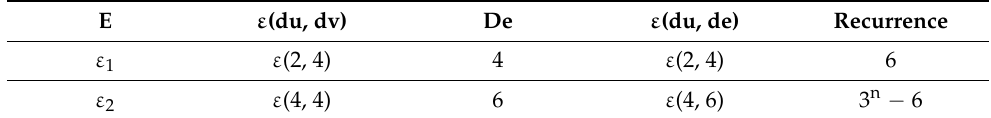
Table 7. Edge partition of Sierpinski (S n ).